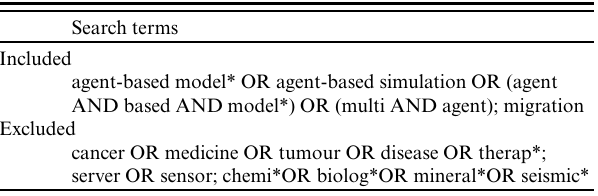
Table 1 . Search terms used for the Web of Science topic